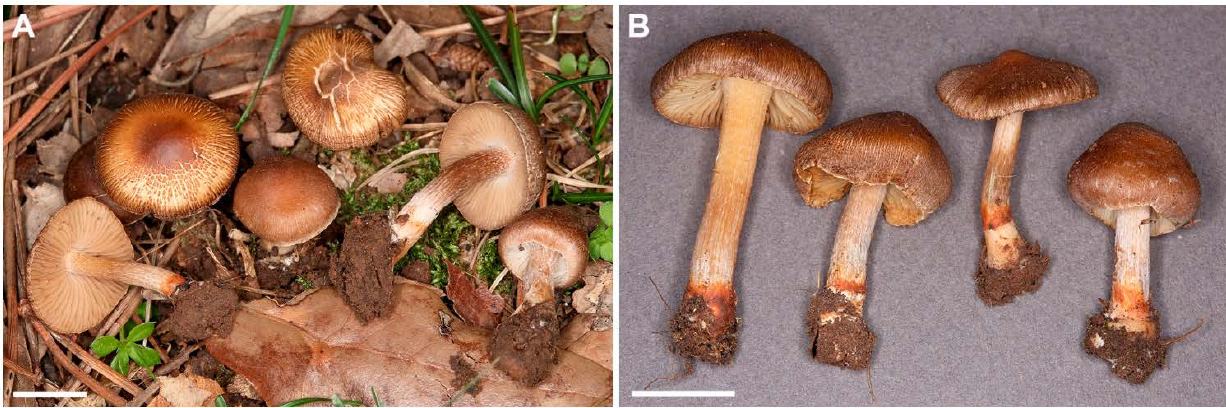
Figure 2. Inocybe brijunica (CNF 1/7345, holotype). ( A ) Basidiomata in situ. ( B ) Basidiomata in lab. Bars: A, B = 10